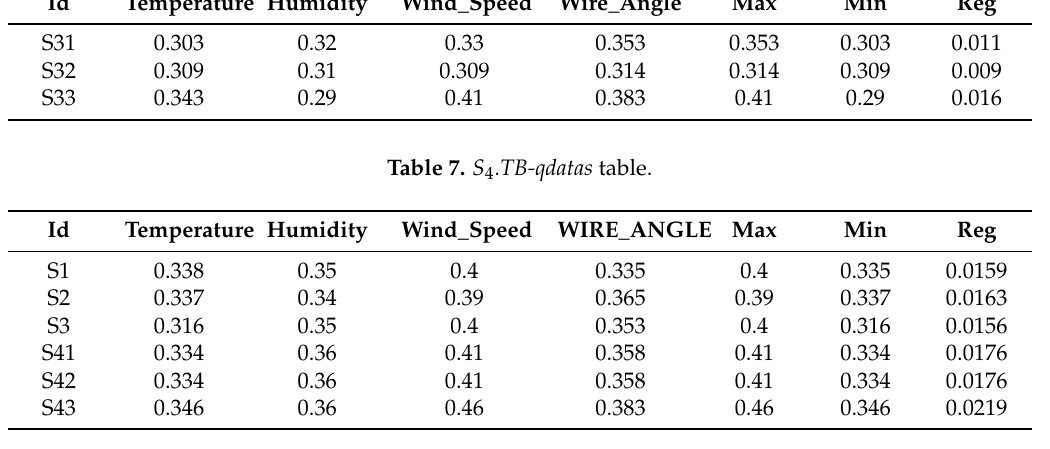
Table 8. The TB_Sfilters table of S 4